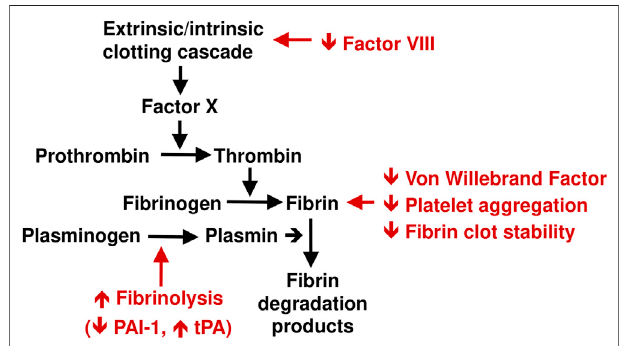
FIGURE 3 | Schematic summary of antithrombotic effects of metformin (shown in red). See text for references. PAI-1, plasminogen activator inhibitor- 1; tPA, tissue plasminogen activator.